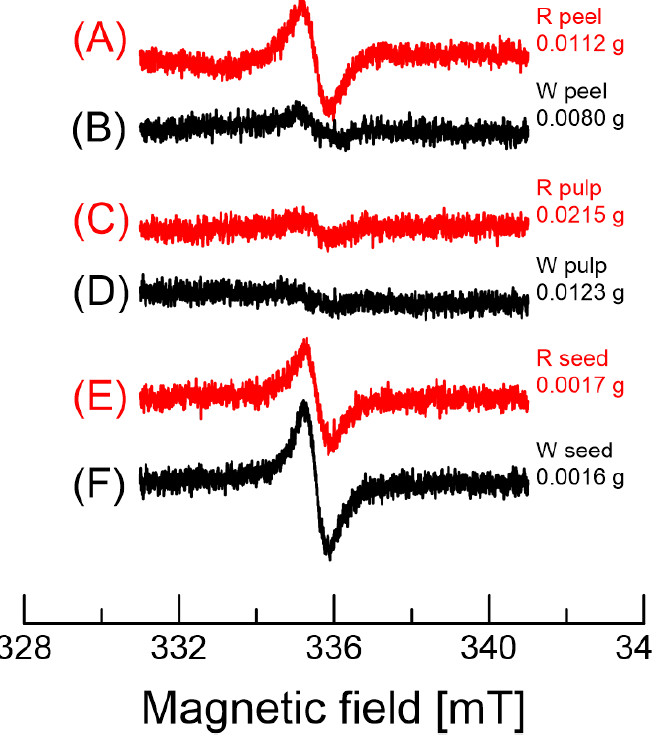
Figure 8. EPR spectra of various parts of dragon fruits. ( A , B ) show the spectra of the peel of red and white dragon fruits, respectively. ( C , D ) show the spectra of the pulp of red and white dragon fruits, respectively. ( E , F ) show the spectra of the seeds of red and white dragon fruits, respectively. The sample weight measured is indicated at the right side of each spectrum. Table 3. EPR peak-to-peak line width of dragon fruits. Red